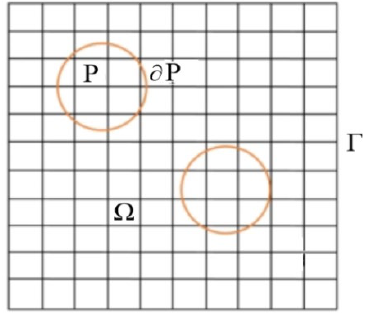
Figure 2. Diagram of different domains.